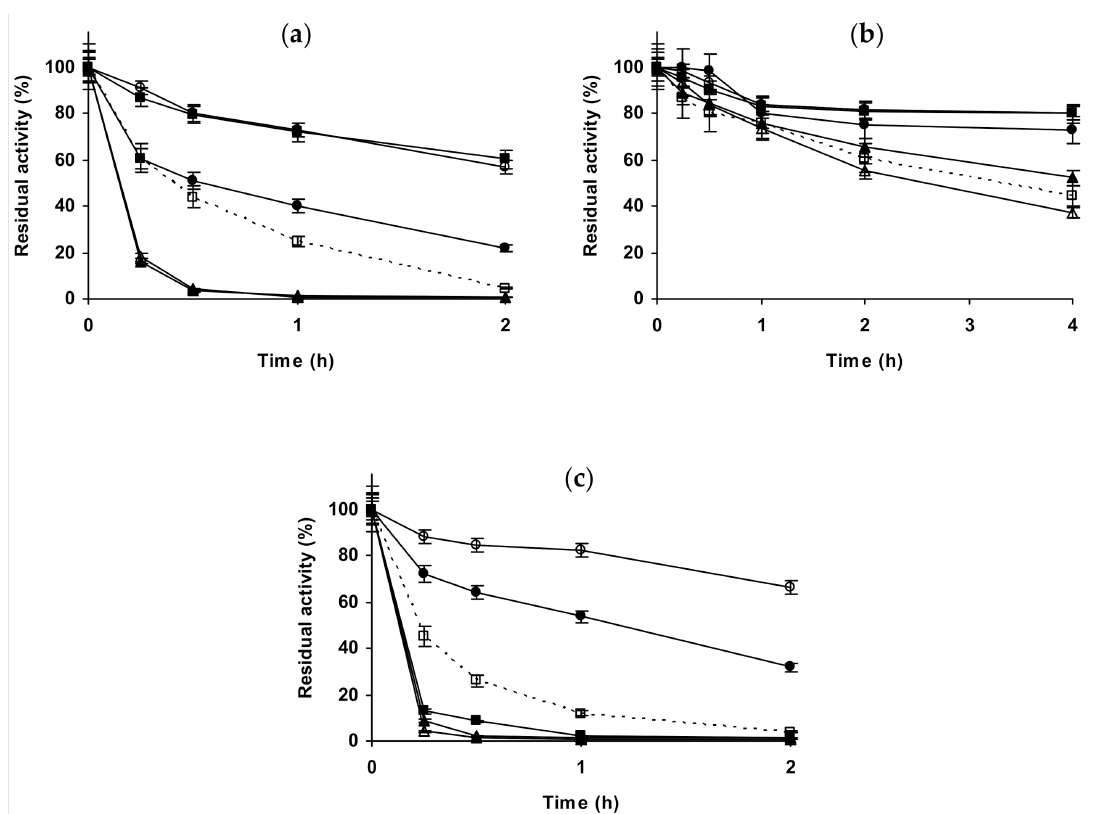
Figure 13. Effect of ionic strength and inactivation pH on the stability of glutaraldehyde-catalase. ( a ) pH 5.0 and 50 ◦ C; ( b ) pH 7.0 and 50 ◦ C; ( c ) pH 9.0 and 47 ◦ C. Other specifications are described in the Methods section. Dotted line, empty squares: references; full triangles: 1 M NaCl; empty triangles: 3 M NaCl; full circles: 1 M (NH 4 ) 2 SO 4 ; empty circles: 3 M (NH 4 ) 2 SO 4 and full squares: 1 M Na 2 SO 4